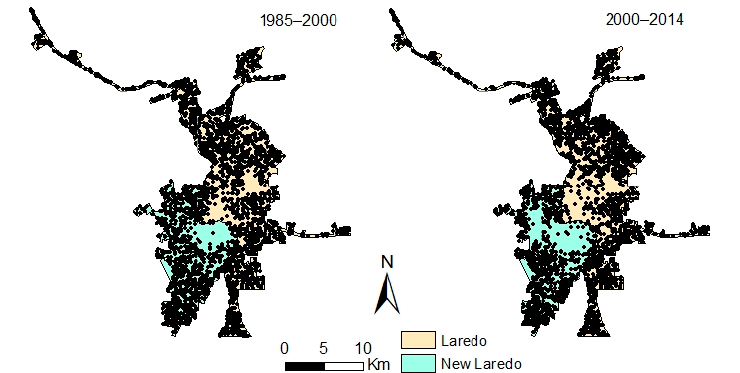
Figure 6. The location of the systematic random sample points for the time periods 1985–2000 and 2000–2014, respectively.